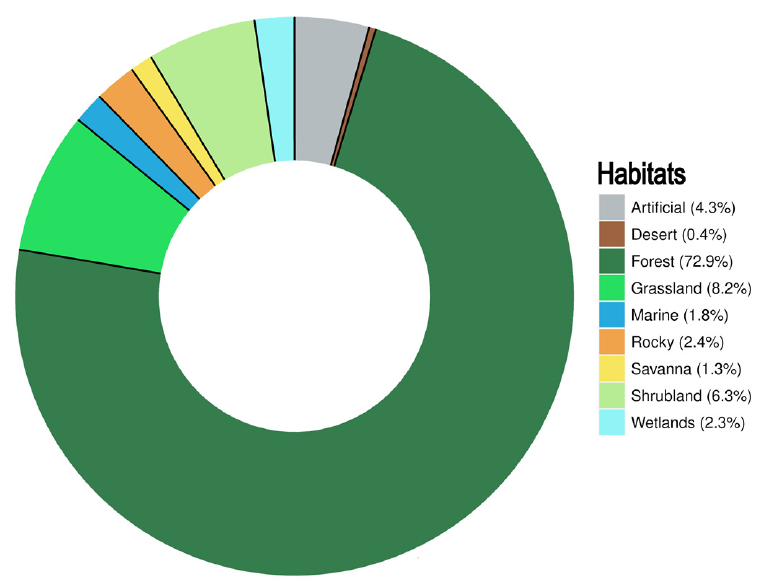
Figure 7. Proportion of assessed fungi species in the different main habitats. Note that species may be present in more than one habitat.